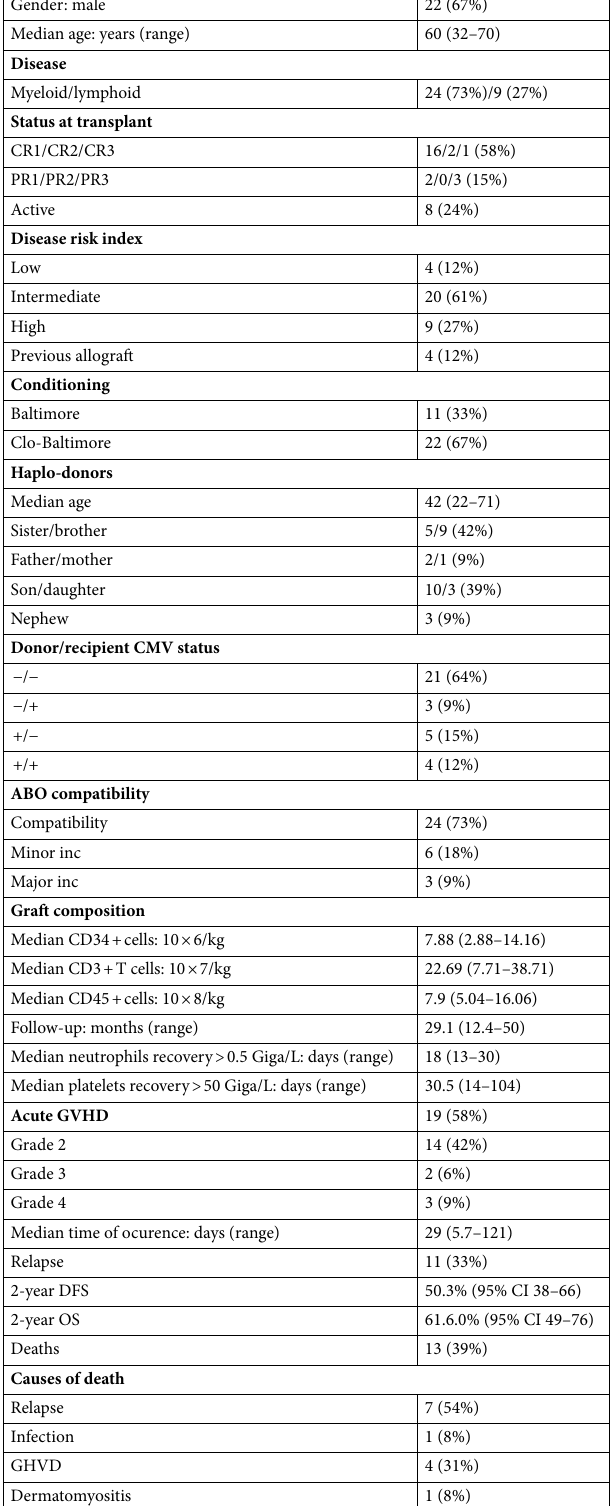
Table 2. Characteristics and outcome of patients. CR complete remission, PR partial remission, CMV